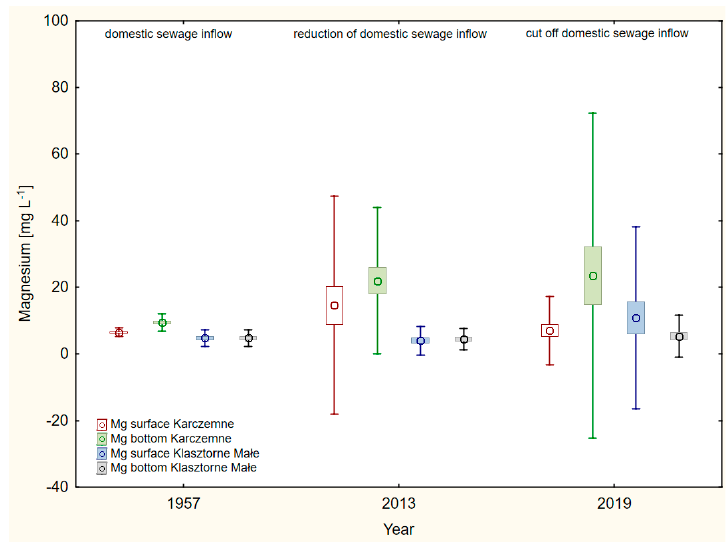
Figure 7. Mean annual values of magnesium content (box ± SEM; whisker plots ± SD) in the water of Karczemne and Klasztorne Małe lakes.